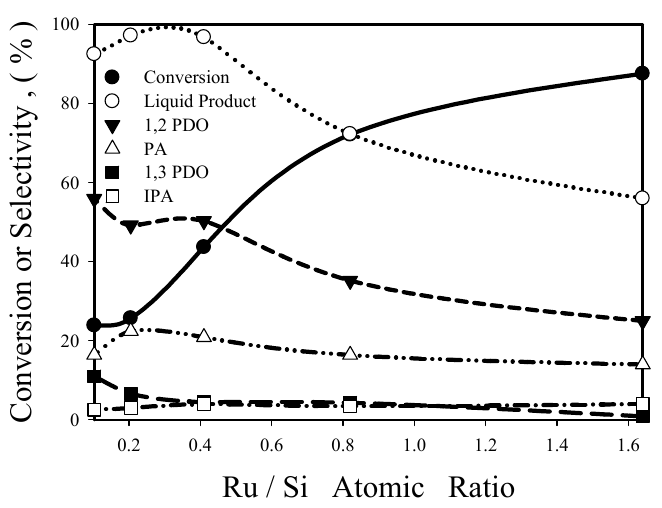
Figure 9. Influence of Ru/Si atomic ratio on glycerol conversion and product selectivity.